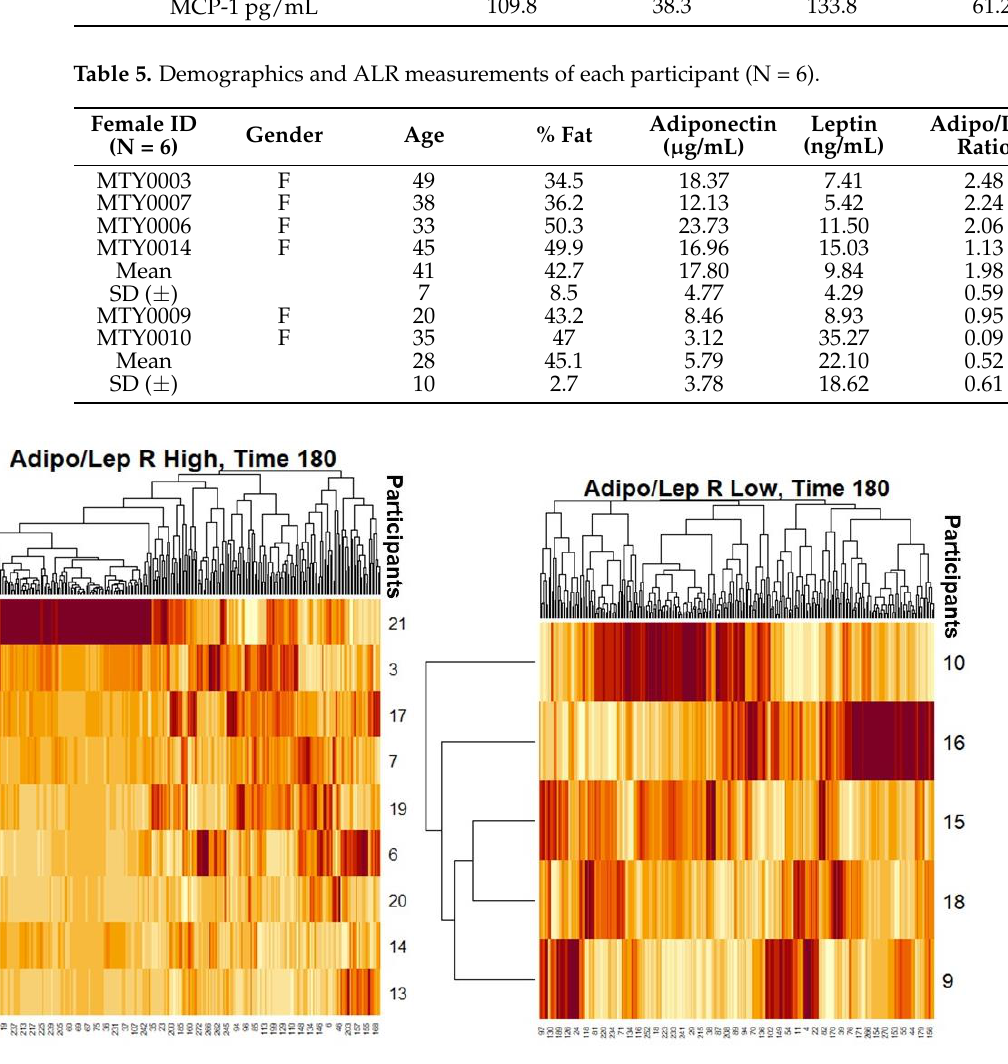
Figure 2. Heat maps with differences in lipidomics signatures for Time 180 ′ (peak of postprandial response) after a mixed meal among participants with (H) vs. (L)ALR.